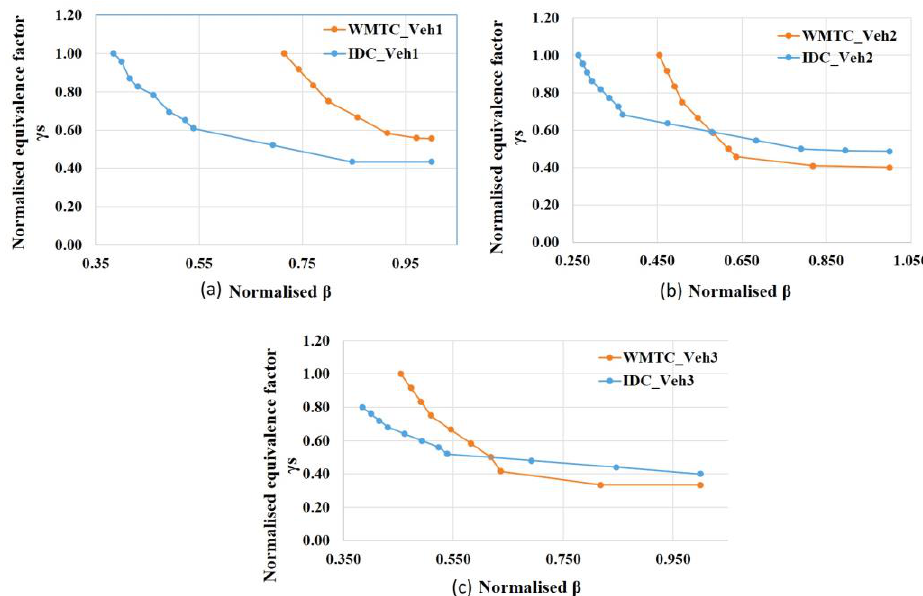
Figure 7. Relationship between the new equivalence factor ‘γs’ and gain ‘ 𝛽 ’ for 3 different system configurations: ( a ) Veh1, ( b ) Veh2 and ( c ) Veh3 tested for WMTC and IDC test cycles